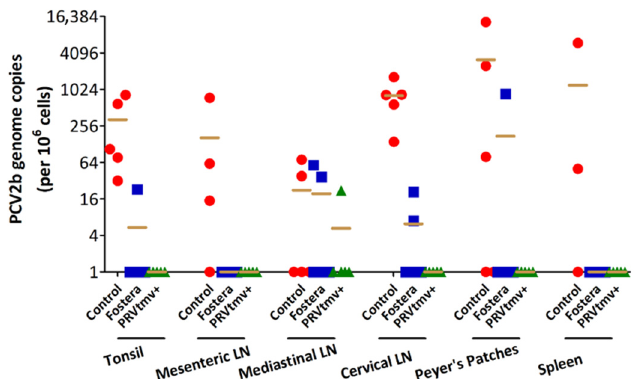
Figure 18. Quantification of PCV2b viral genome copies in pig tissues. DNA was isolated from 25 mg of tissues (tonsil, mesenteric LN, mediastinal LN, cervical LN, Peyer’s patch, and spleen), and PCV2b qPCR was performed. PCV2b genome copy numbers were calculated according to CT-values of a standard curve. Calculated PCV2b genome copies were normalized based on porcine house-keeping gene GAPDH, and shown are the mean copy numbers of PCV2b genome per one million cells. Two independent qPCR analyses were performed for each animal from three vaccination groups. The dot plot graph represents the mean + individual values in each group ( n = 5).